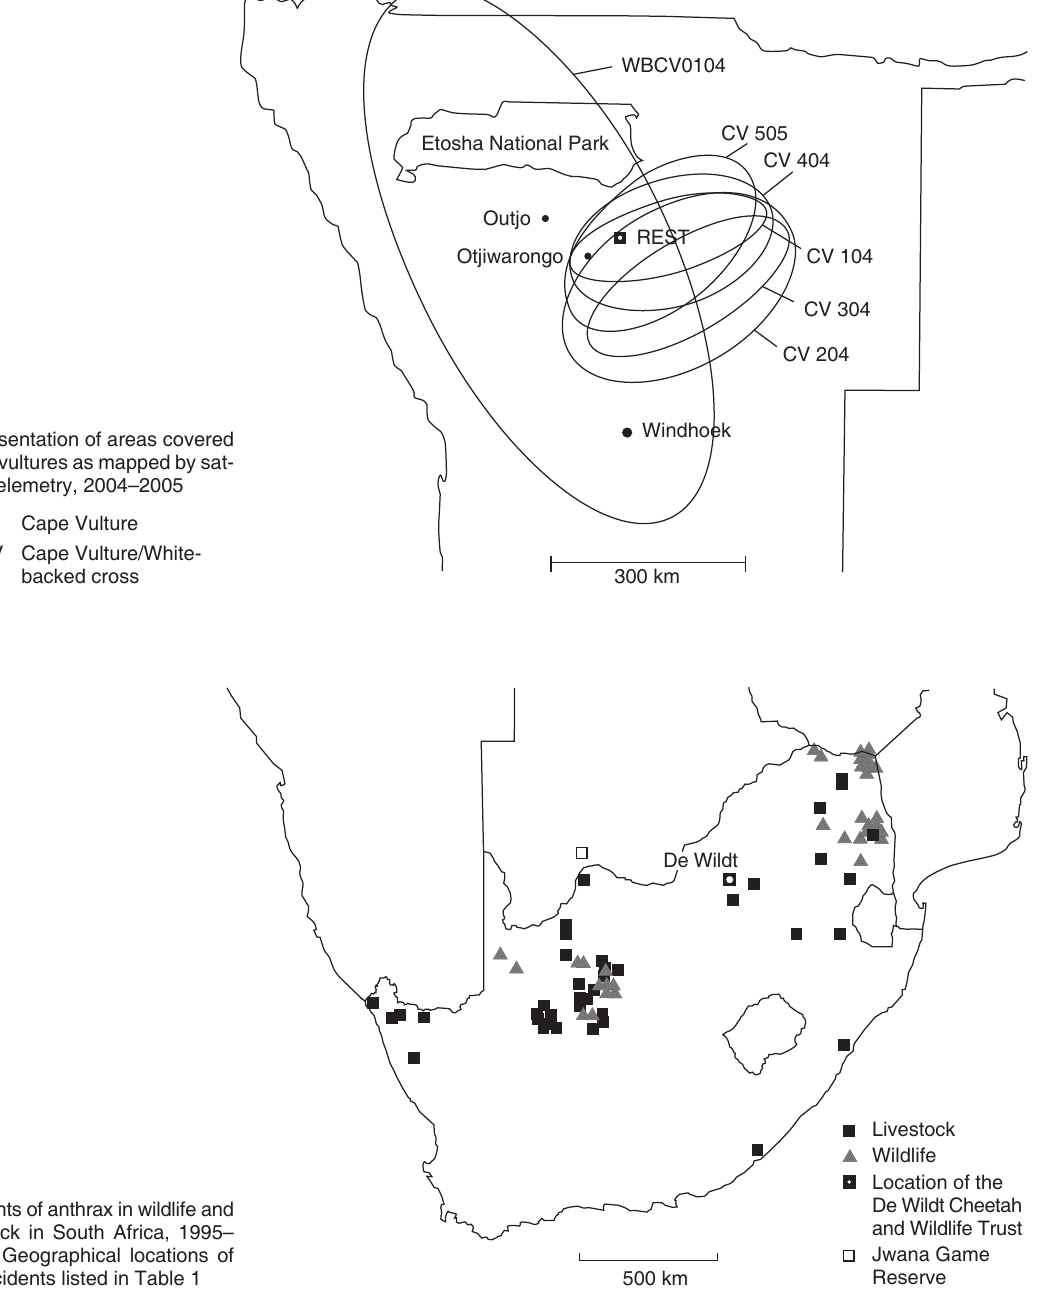
FIG. 2 Incidents of anthrax in wild life and livestock in South Afri ca, 1995– 2005. Geo graph ical locations of the incidents listed in Table